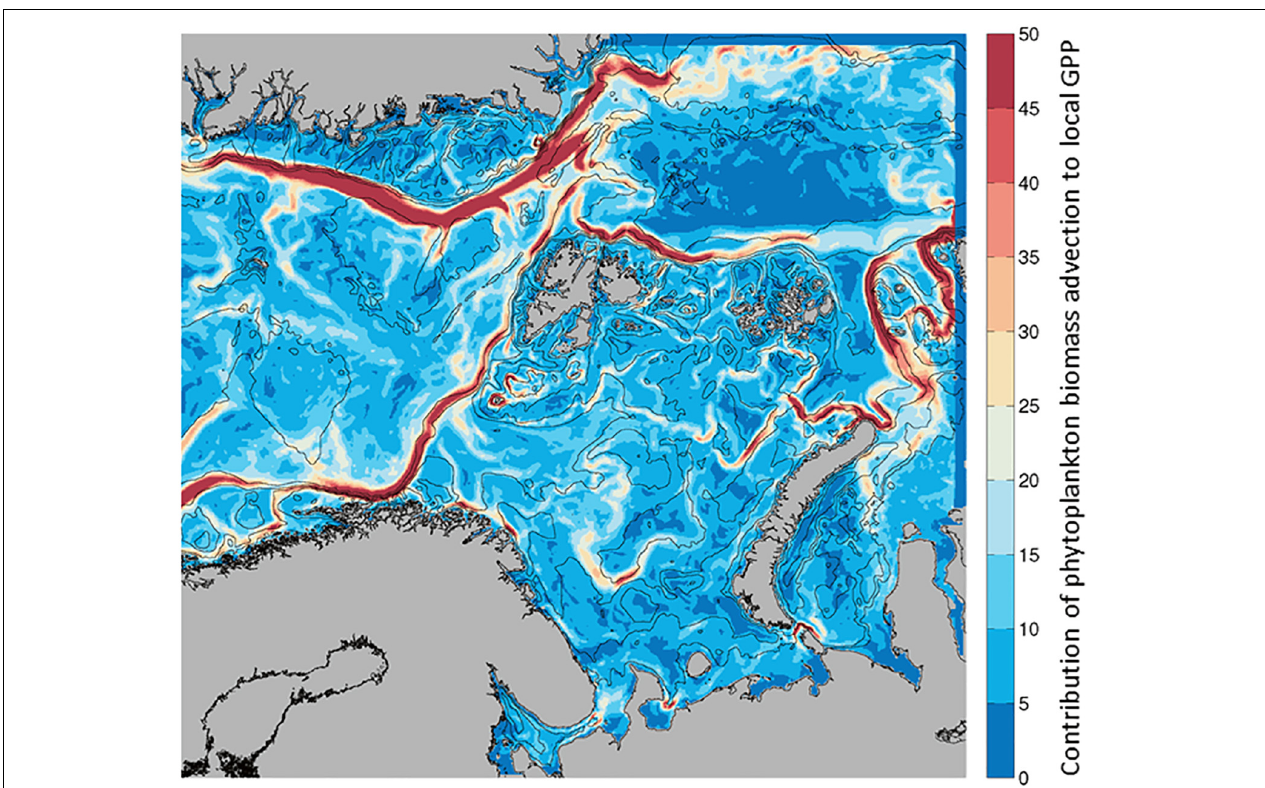
FIGURE 6 | Average contribution of Phytoplankton Biomass Advection to local Gross Primary Production estimated as Biomass advected IN/GPP (no units), from April to September. Low contribution of advection (blue) to high (red) from 0 to 50 times higher Phytoplankton Advection than local